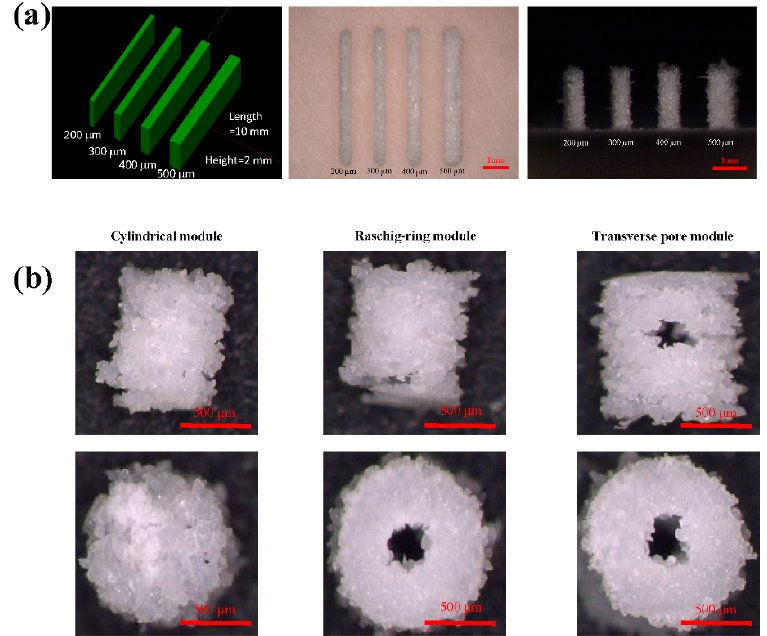
Figure 2. ( a ) Rectangular layers of varying thicknesses. ( b ) Three types of modules fabricated with PGA powder using modified selective-laser-sintering (SLS) technology.